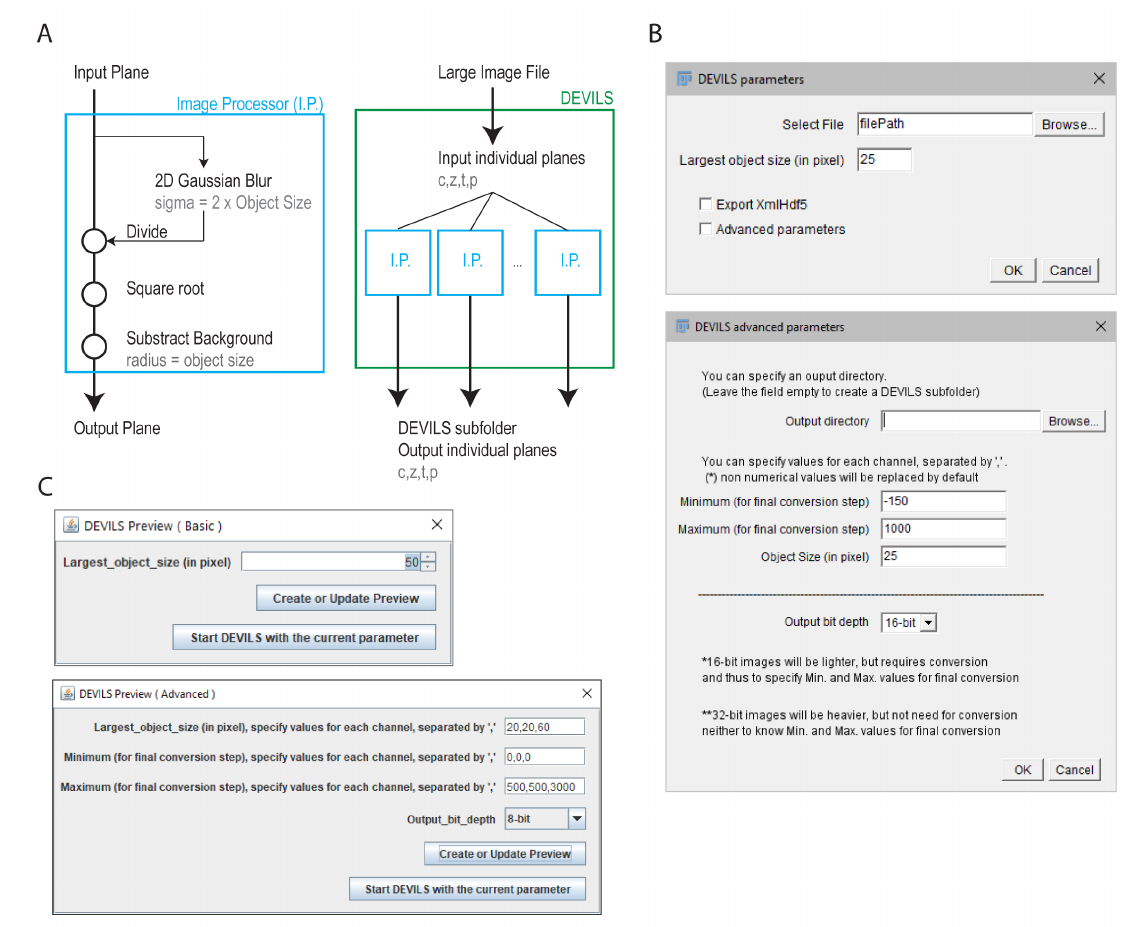
Figure 2. Implementation of DEVILS in ImageJ/Fiji. ( A ) Schematic workflow of the DEVILS ImageProcessor (IP) operation and its parallelization in order to handle large image stacks. ( B ) Graphical user interface of the plugin. In the standard mode, only the image location and the parameter p is required from the user. The advanced mode enables the user to define the output directory, define an object size per channel, minimum and maximum values for conversion (necessary with 8-bit and 16-bit output) and the output bit depth (8-, 16- or 32-bit). ( C ) Graphical user interface of the preview